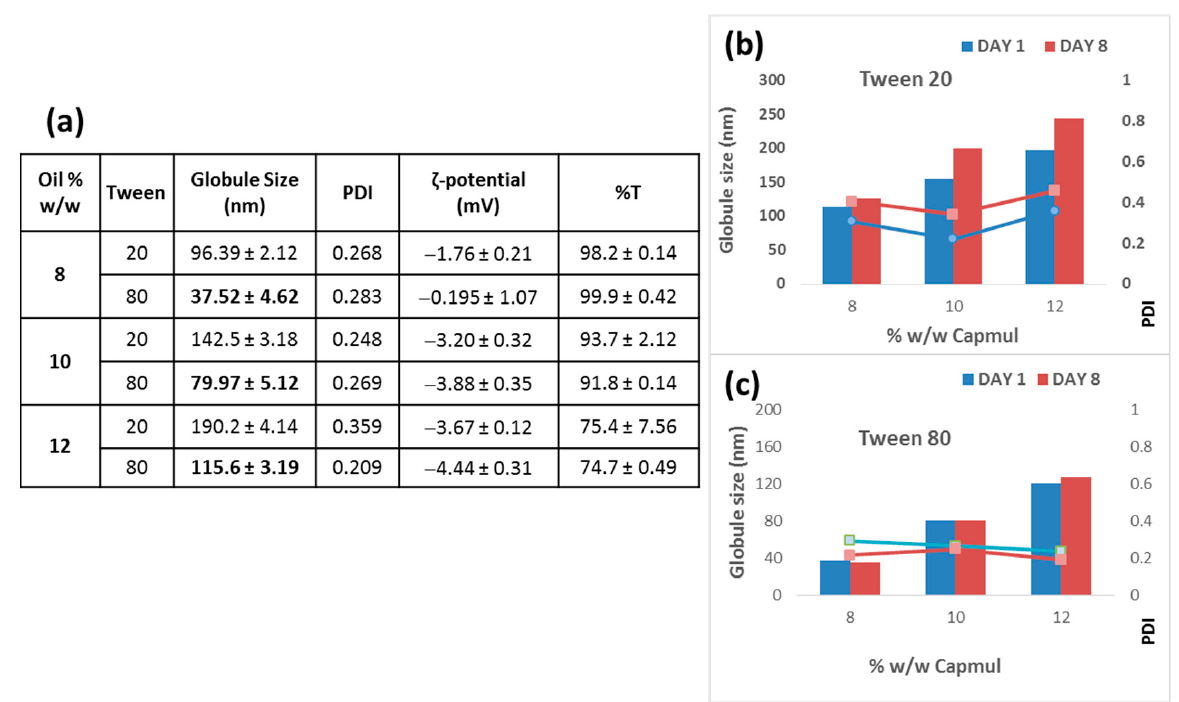
Figure 4. ( a ) Physicochemical properties of NEs composed of Tween 20 or Tween 80 (as the surfactant). ( b ) Stability of Tween 20 containing NEs (for 8 days at 25 °C). ( c ) Stability of Tween 80-containing NEs (for 8 days at 25 °C).